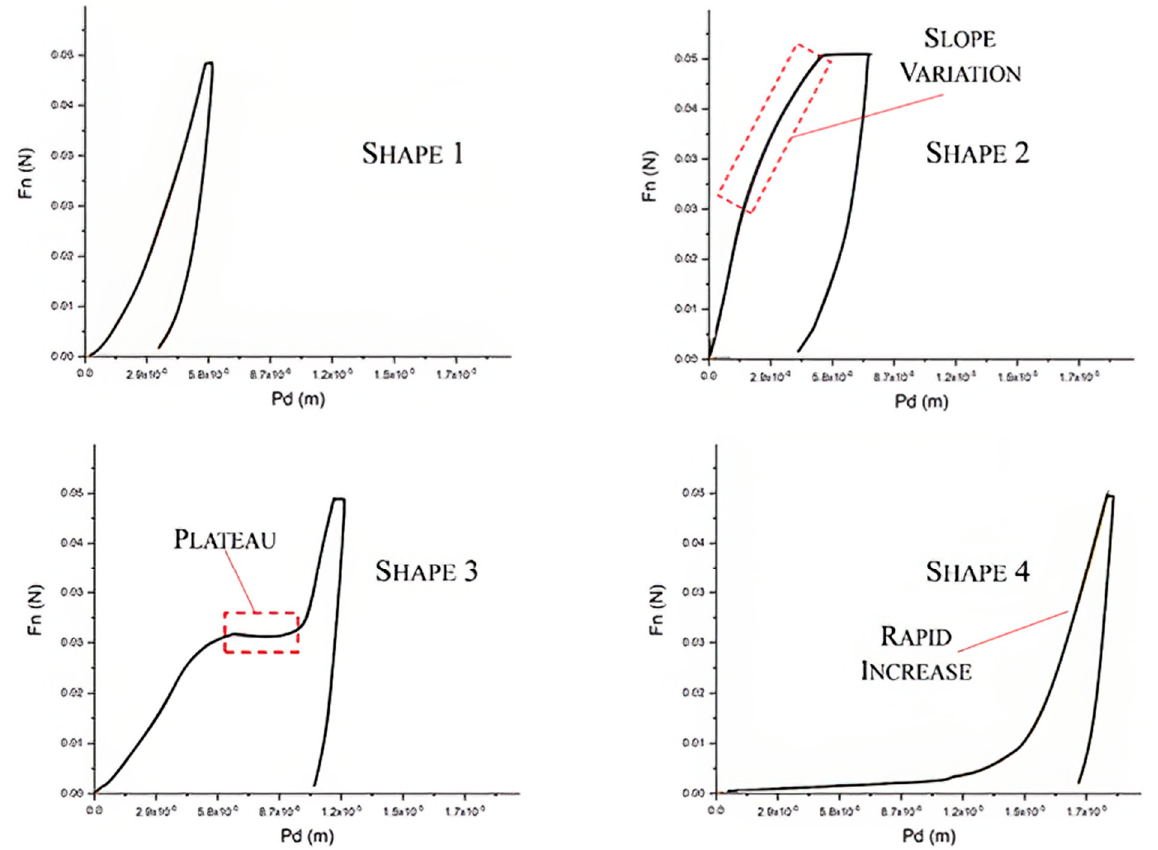
Figure 11. Different shapes of the load-penetration depth curves observed indenting the coated specimens.